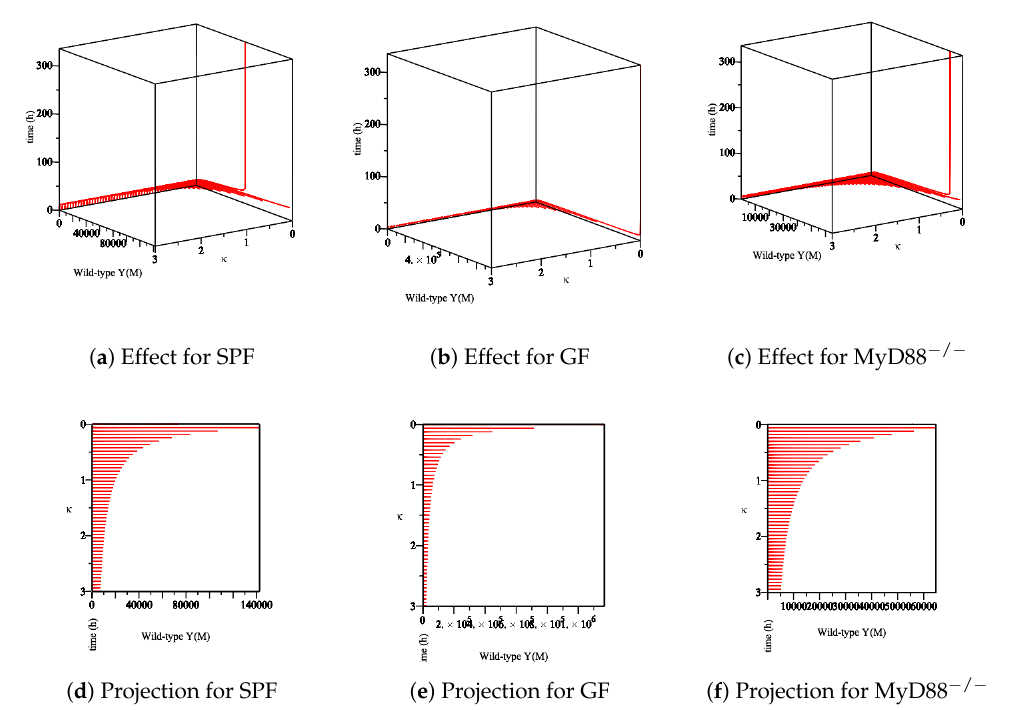
Figure 7. The sensitivity of parameter κ in the elimination of wt Yersinia strain in the mucosa. ( a – c ) The effect of the parameter κ on the different types of mice. ( d – f ) The projection of κ for a different types of mice.